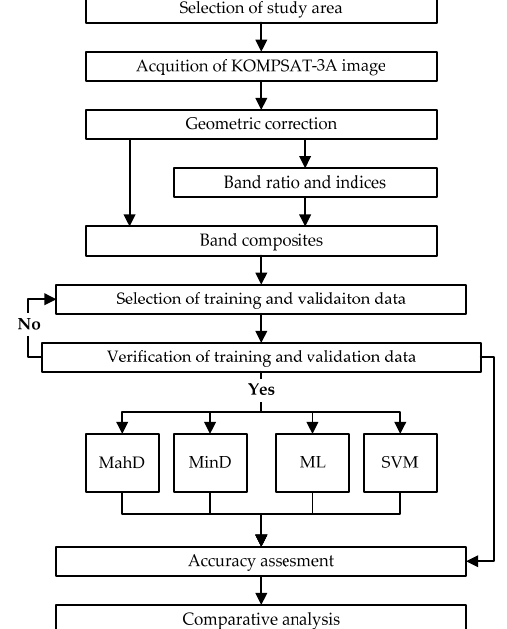
Figure 1. Overall process adopted in this study where land cover classification of Korea Multi-Purpose Satellite (KOMPSAT)-3A image was done using four supervised methods i.e. Mahalanobis Distance (MahD), Minimum Distance (MinD), Maximum Likelihood (ML) and Support Vector Machine (SVM).